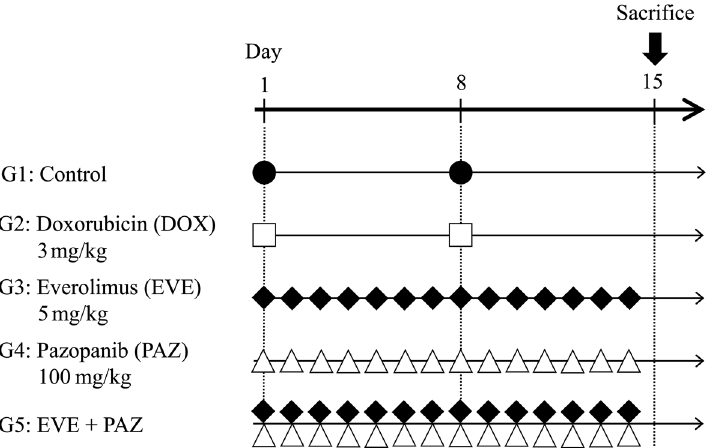
Figure 1. Treatment schema in an osteosarcoma PDOX model and in vivo Gelfoam angiogenesis model. Treatment started on day 1 and ended on day 15. Group 1, untreated control with PBS, i.p.; Group 2, DOX alone, 2.4 mg/kg, i.p., weekly for 2 weeks; Group 3, EVE alone, 3 mg/kg, oral gavage, daily for 2 weeks; Group 4, PAZ alone, 50 mg/kg, oral gavage, daily for 2 weeks; Group 5, treated with EVE and PAZ, 3 mg/kg and 50 mg/ kg, respectively, oral gavage, daily for 2 weeks. Black circles, white squares, black squares and white triangles show administration schedule for each